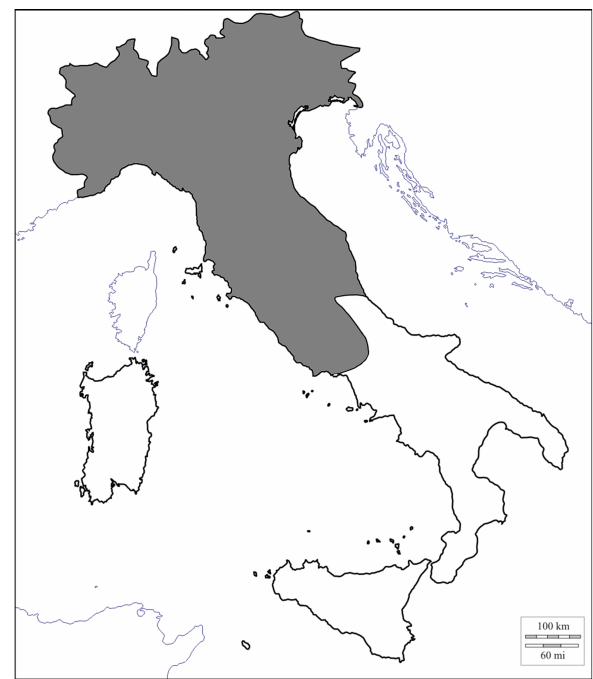
Figure 11. Distribution map of Microtus savii (redrawn from Bezerra et al. 2016).